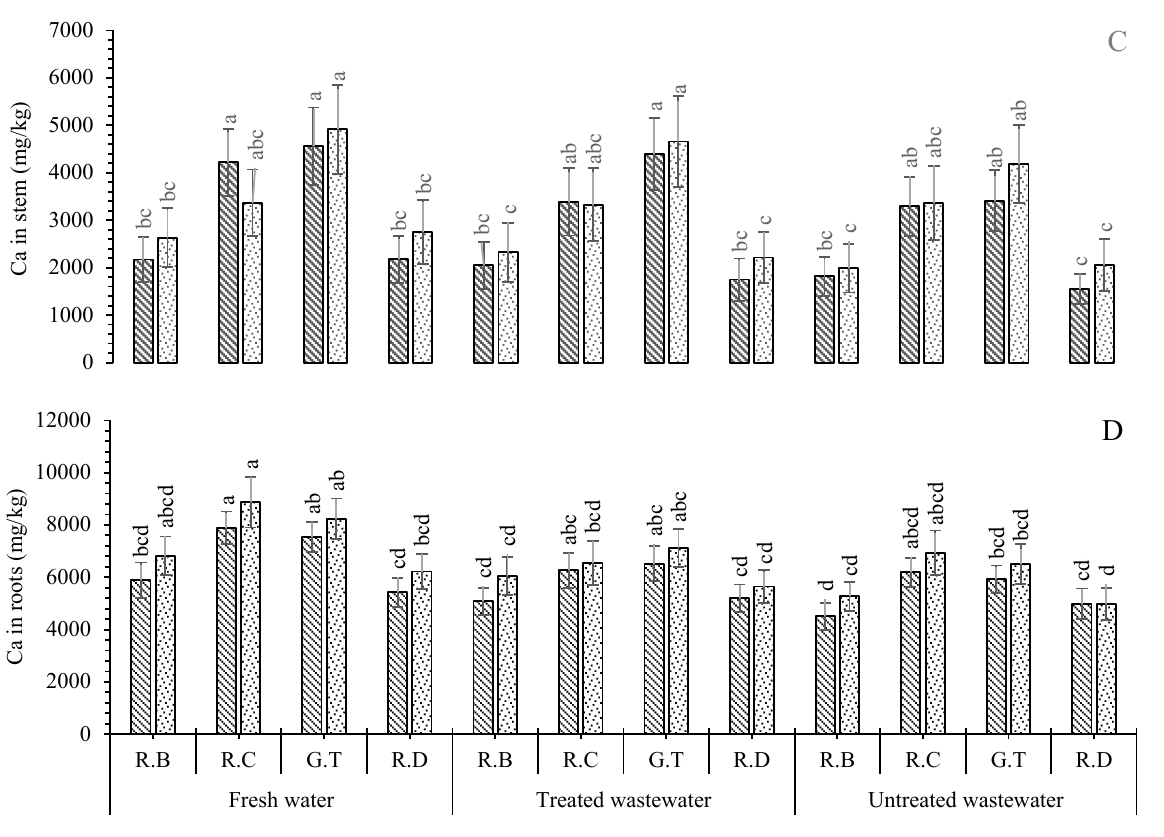
Figure 4. Mean concentration of K in plant parts, i.e., flowers ( A ), leaves ( B ), stems ( C ), and roots ( D ), of Rosa species under different irrigations. Each vertical bar represents the average of three replicates. Different letters indicate significant differences among treatments at p ≤ 0.05 according to least significant difference test. R.B: Rosa bourboniana , R.C: Rosa centifolia , G.T: Gruss-an-teplitz, R.D: Rosa damascena.